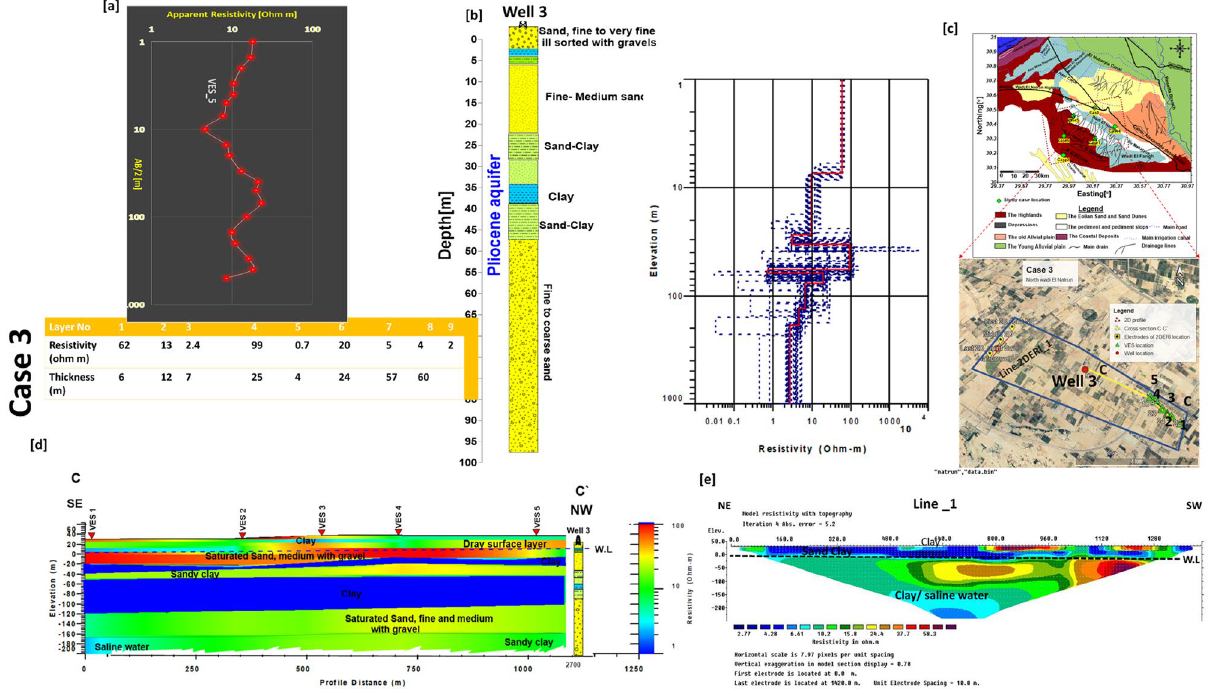
Figure 7. ( a ) VES1 as example for case 3 with Well 3, ( b ) inverted model with cumulative models, ( c ) the location of C–C ′ cross section in the study area, ( d ) inverted resistivity cross section CC ′ in the third study area. ( e ) Line_1 of 2DERI in the opposite direction of C–C ′ cross-section of